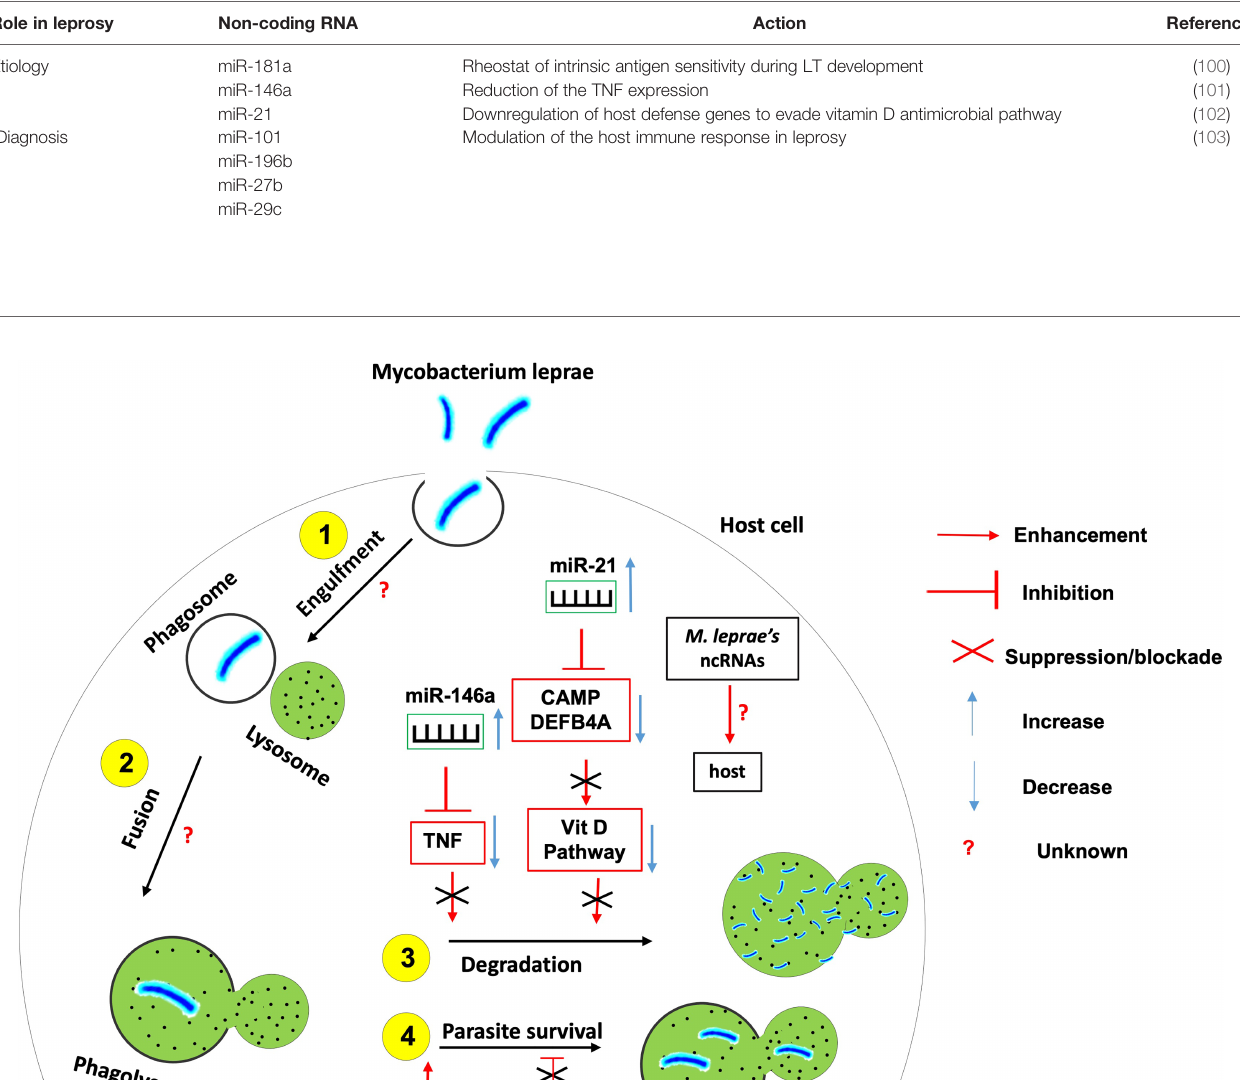
TABLE 4 | Non-coding RNAs in the etiology and control of